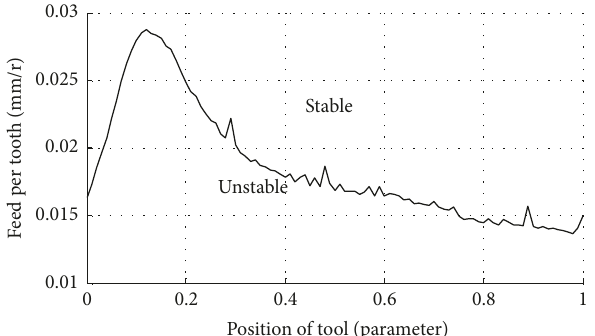
Figure 9: Maximum feed per tooth versus tool position.